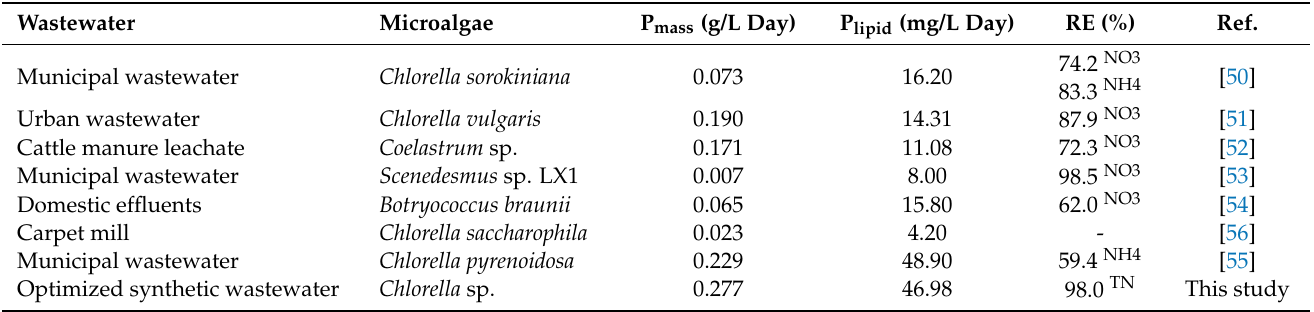
Table 5. Comparison of biomass productivity (P mass ), lipid productivity (P lipid ), and nitrogen removal efficiency (RE) in the present study under optimized conditions with previous studies.